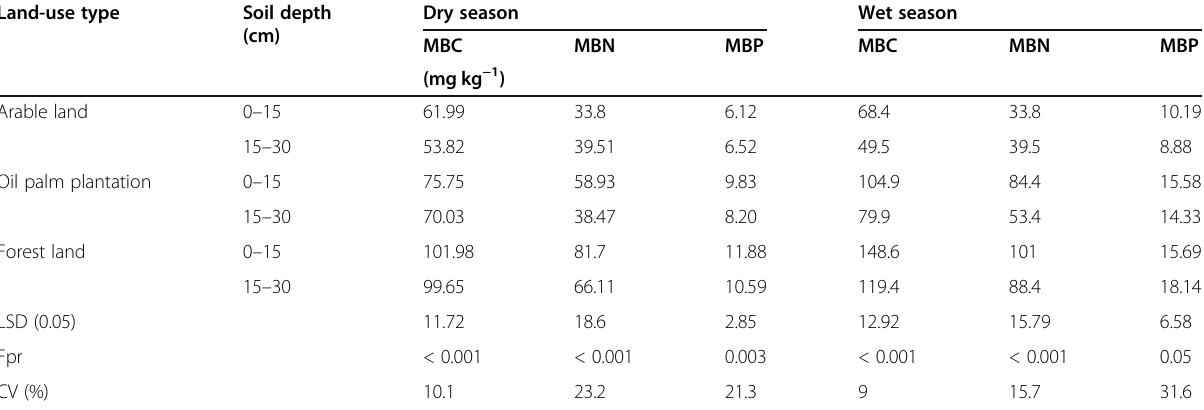
Table 3 Soil microbial biomass C, N and P in the land-use systems Land-use